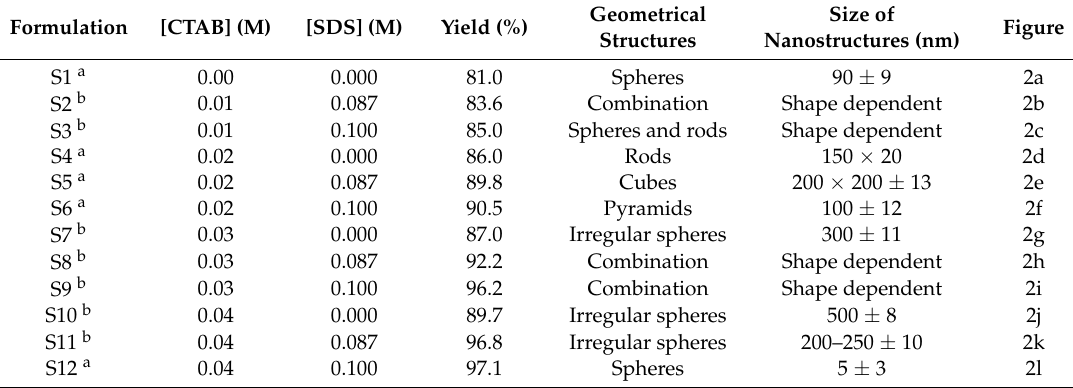
Table 1. Surfactant variations corresponding to physicochemical characteristics of synthesized CuNPs, Data presented are mean ± SE of three experiments performed in duplicate. * p ≤ 0.05.